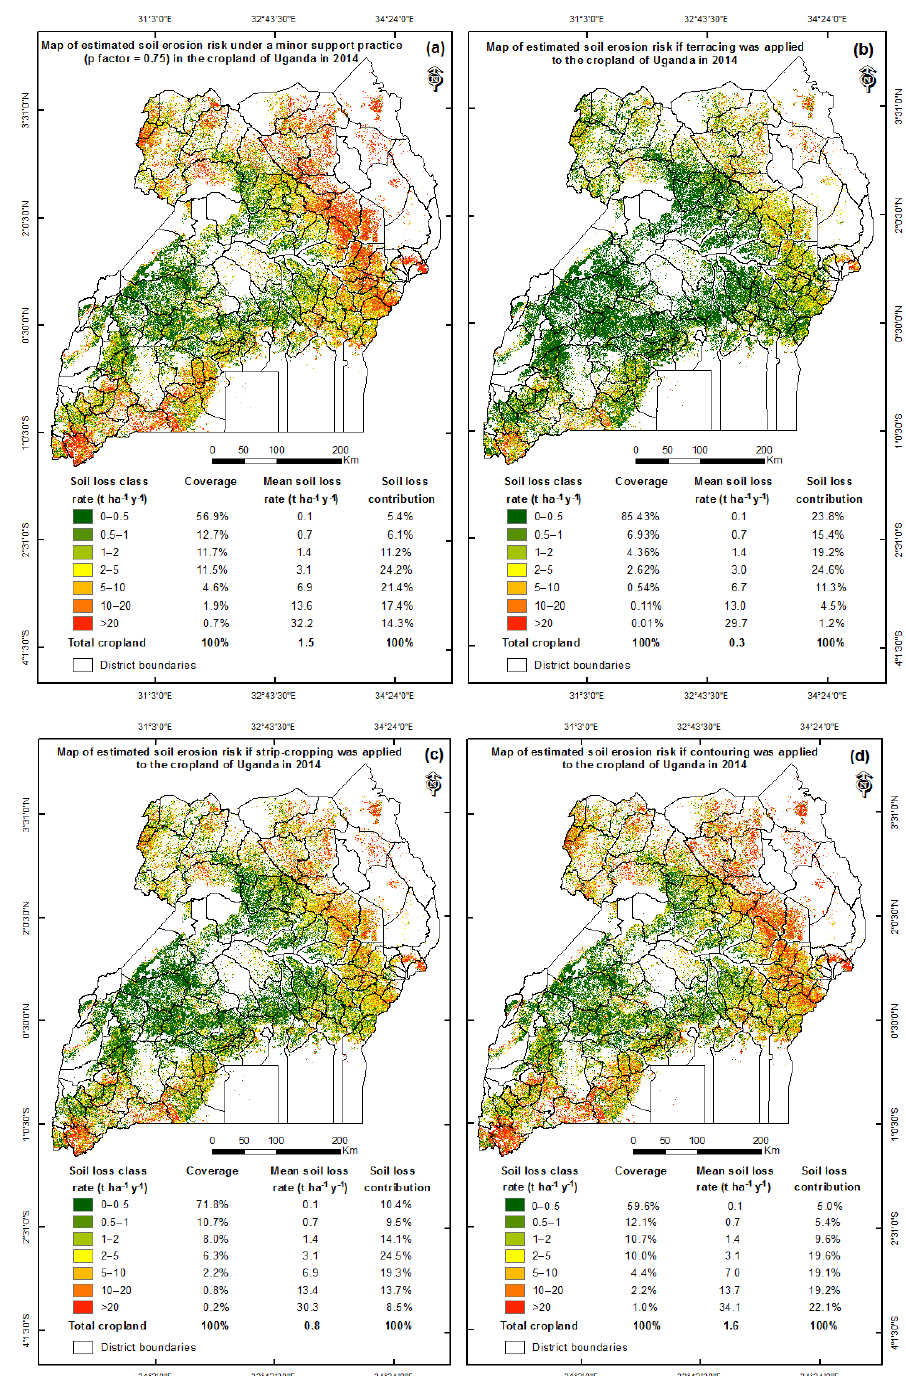
Figure 8. Maps of the estimated soil loss risk for Uganda’s croplands (86,341.86 km 2 ) under different support practices: ( a ) minor conservation in 2014 (P = 0.75); ( b ) terracing; ( c ) strip ‐ cropping; and ( d ) contouring.